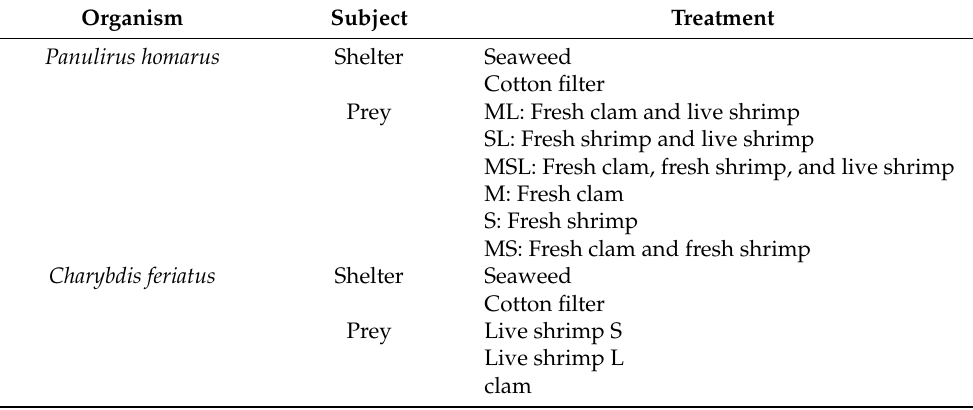
Table 1. Experimental